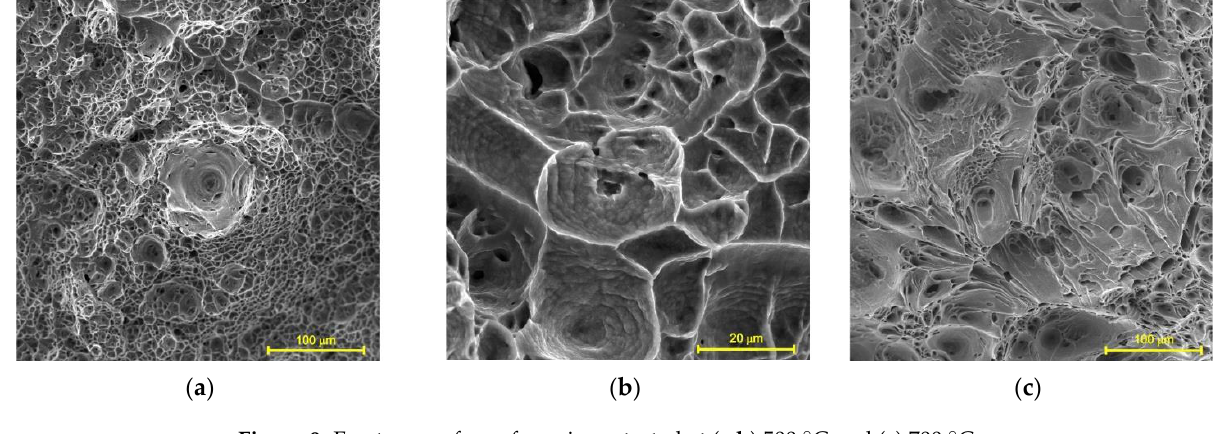
Figure 9. Fracture surface of specimen tested at ( a , b ) 500 °C and ( c ) 700 °C.